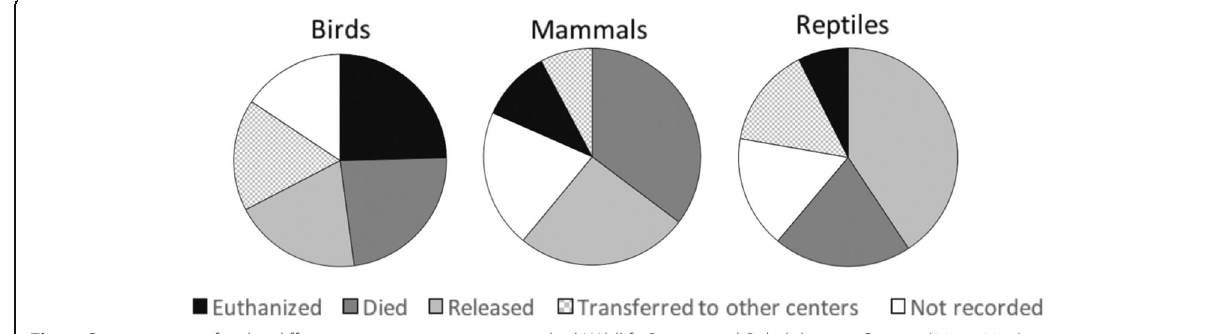
Fig. 5 Case outcomes for the different taxonomic groups in studied Wildlife Rescue and Rehabilitation Centers (2011 –